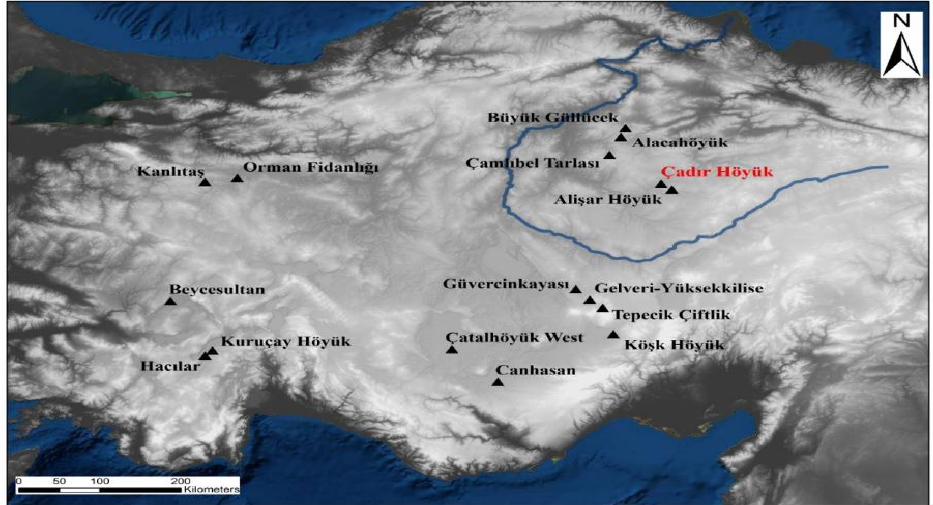
Figure 1. Map of Anatolia showing Çadır Höyük as well as other prominent Chalcolithic sites (map courtesy of A. J. Lauricella).